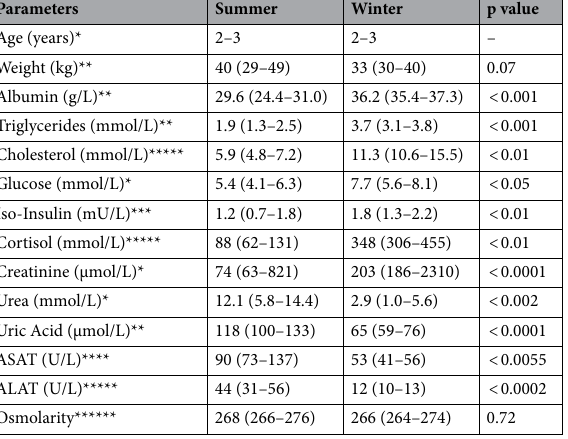
Table 1. Baseline characteristics of bears in summer and winter. *12 pairs of bear sample taken for analysis. **11 pairs of bear sample taken for analysis. **9 pairs of bear sample taken for analysis. ****8 pairs of bear sample taken for analysis. *****5 pairs of bear sample taken for analysis. ******4 pairs of bear sample taken for